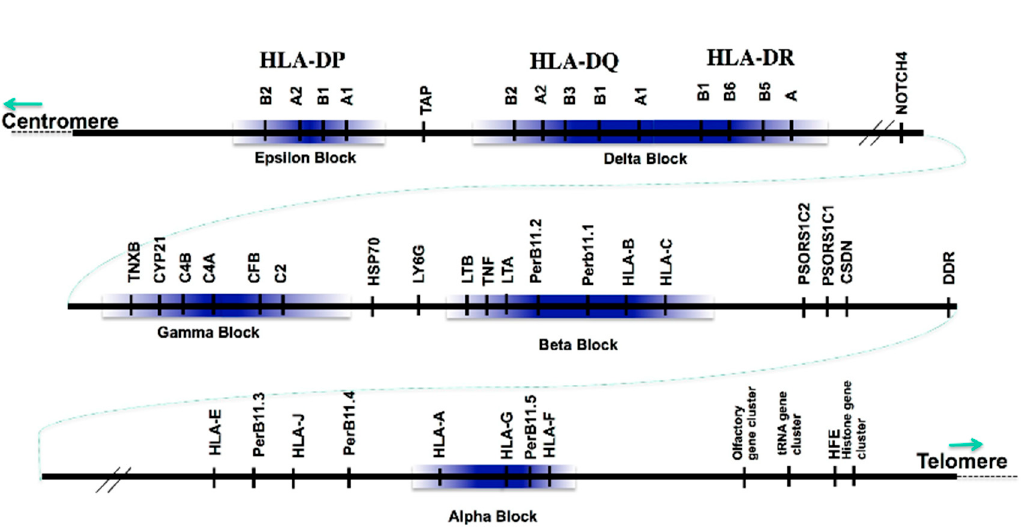
Figure 1. Polymorphic frozen blocks (PFB) in the MHC. Reproduced with permission from [5], and adapted from [16].